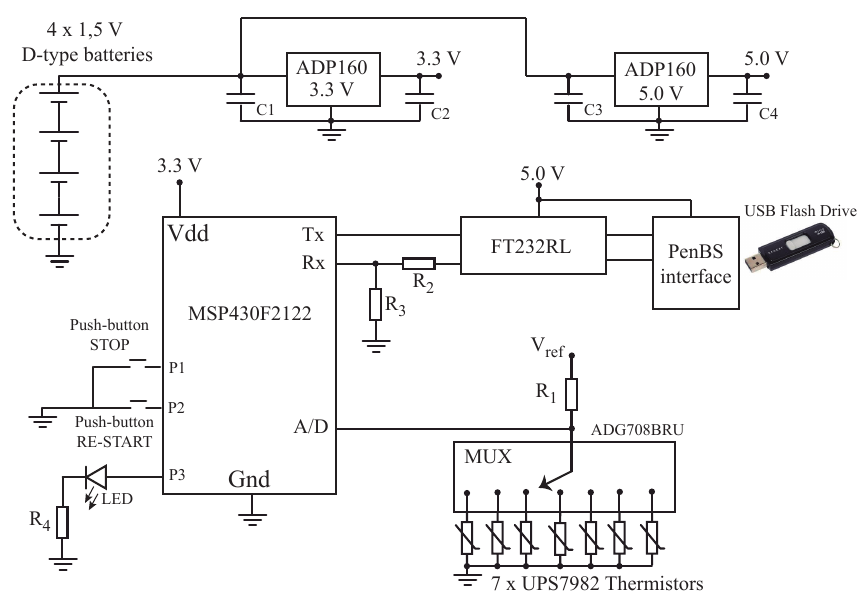
Figure 3. Block diagram of the data-logger for the measurement of the soil